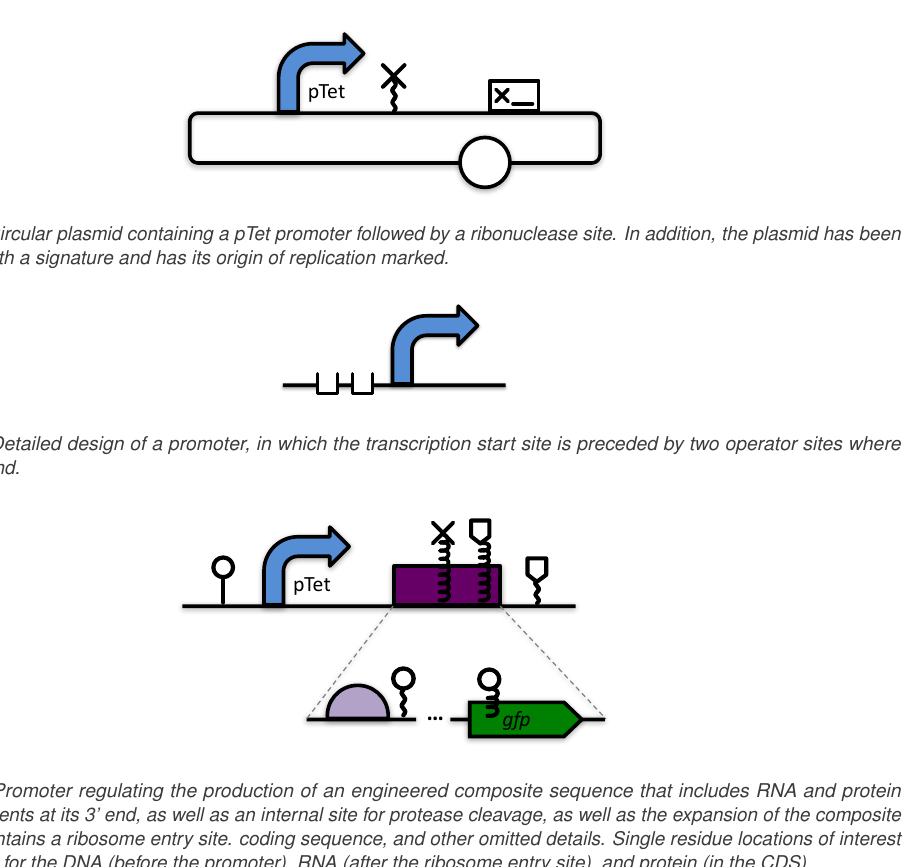
Figure 35: DNA sequence with three primer binding sites.